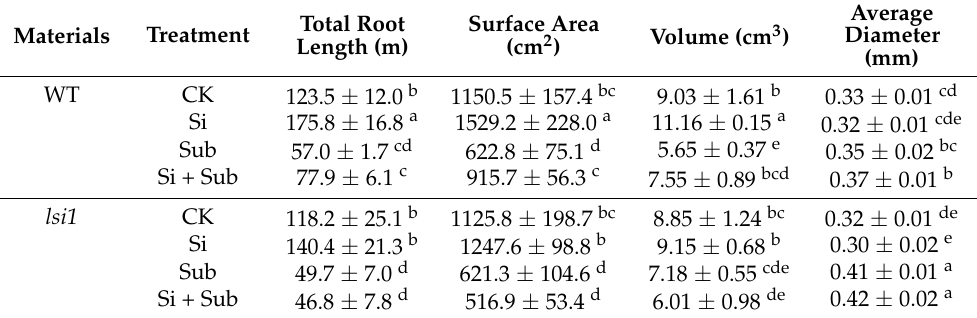
Values are expressed as mean ± SE from three replicates (n = 3). The different letters in the same column indicate significant differences among all treatments ( p < 0.05). WT, wild type.